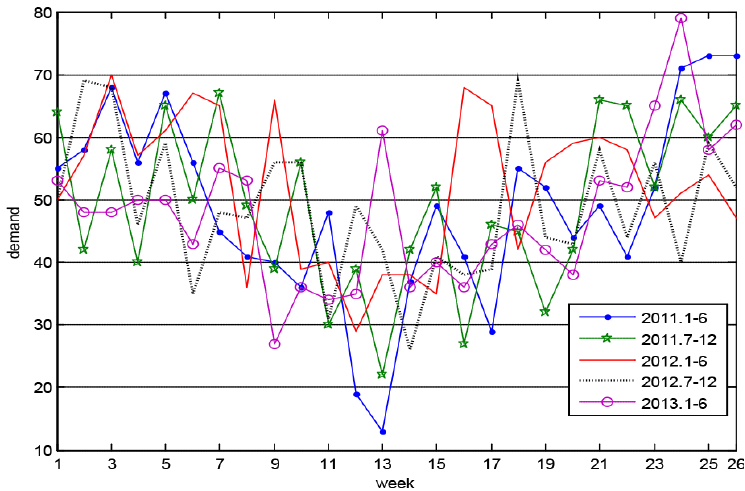
Figure 2. Historical data of influenza vaccine